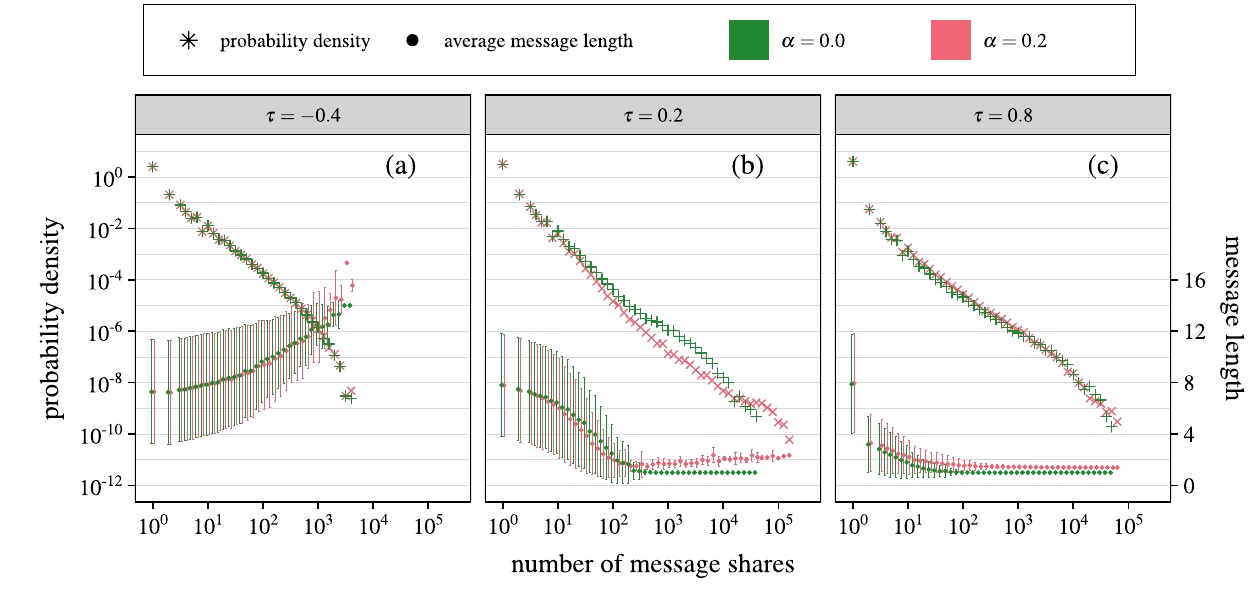
Figure 5. When messages can be re-shared multiple times by the same user, the behavior of the model changes only quantitatively. The graphs presents popularity distribution and average message length for simulations on BA networks of size N = 600 and for 500, 000 time steps. Other parameters are the same as for results shown on Fig. 2. Columns correspond to different selectivity τ = − 0.4 , 0.2, 0.8, green symbols are for simulations without adaptivity ( α = 0 ) while red are with adaptivity ( α = 0.2 ).